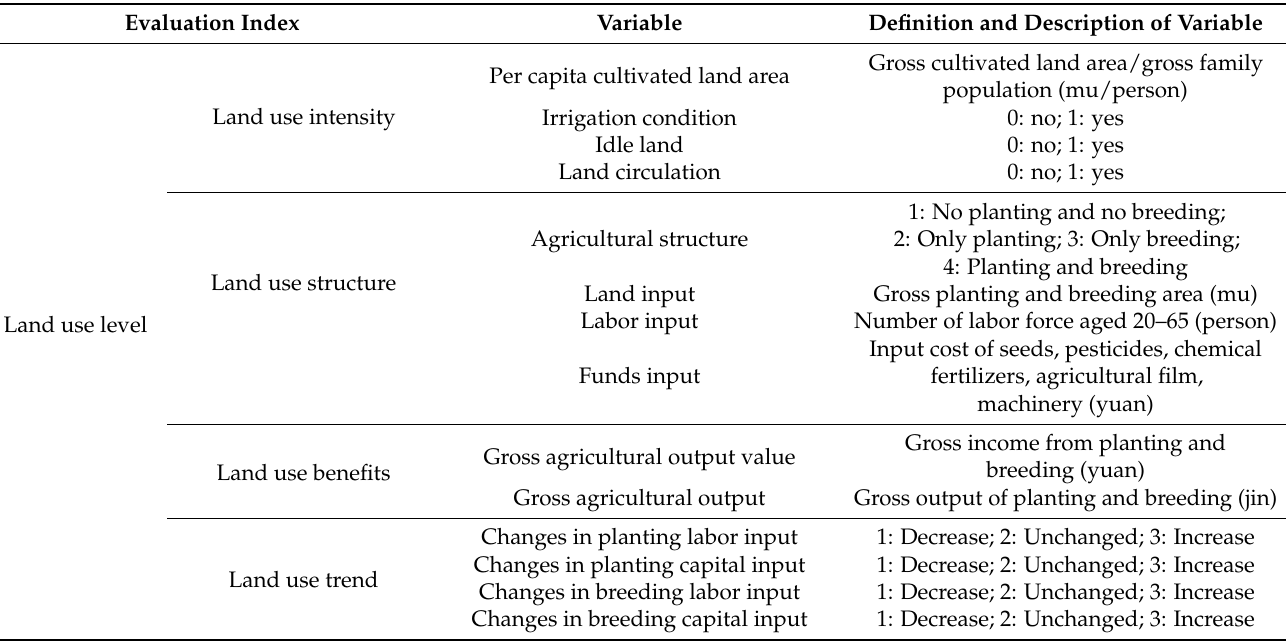
Table 3. The evaluation index system of household land use level.